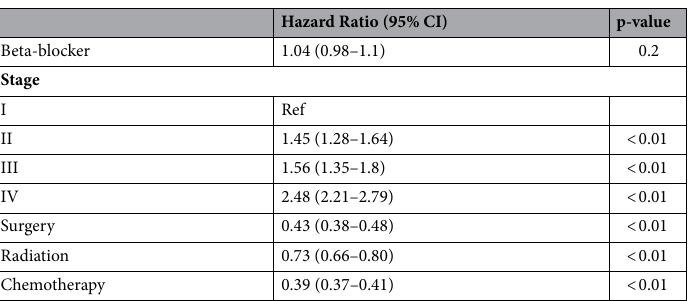
Table 3. Cox-Proportional Hazards model for beta-blockers use before diagnosis, adjusted for tumor stage, cancer-directed surgery, radiation therapy, chemotherapy and propensity score. Propensity score included sex, age, marital status, race, income and Charlson comorbidity